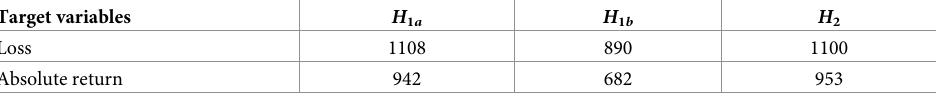
Table 1. The number of trading days (out of total 3334 days) that have at least one Granger-causality test (from lag 1 to lag 5) with a significant result at 0.1 level. The rows are the responses and the columns are the hypotheses tested in the Granger causality tests stated in Eq (9) and Eq